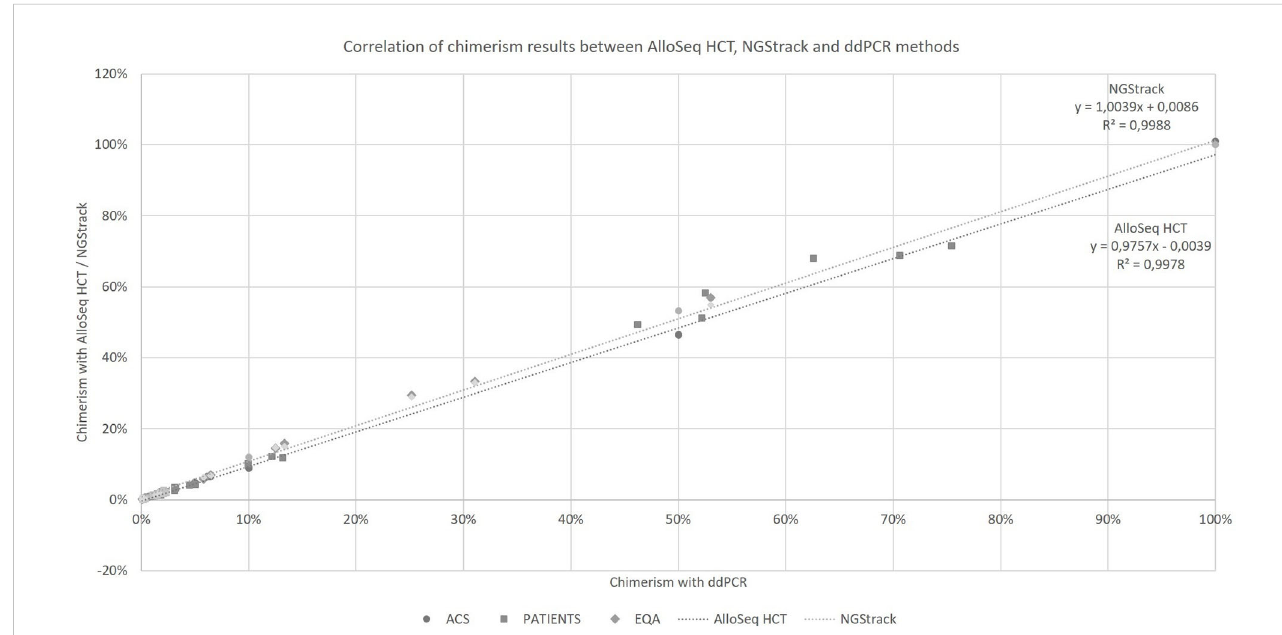
FIGURE 4 Correlation of chimerism results between AlloSeq HCT, NGStrack and ddPCR methods. ACS. Arti fi cial Chimeric Samples; EQA. External Quality